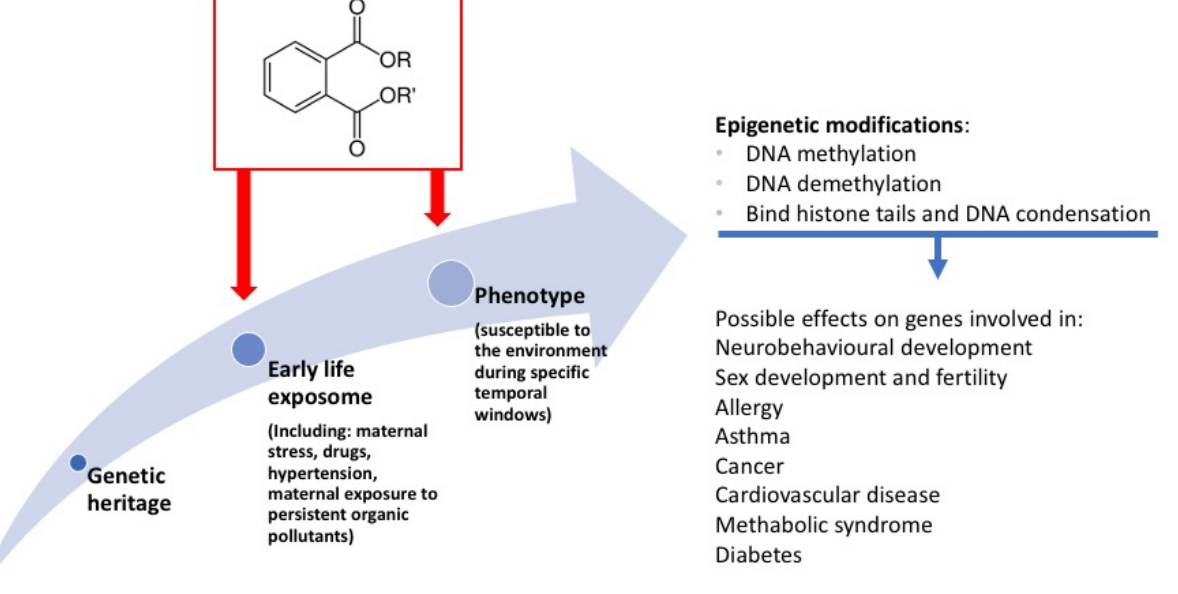
Figure 1. How phthalates may enter in The Development Origin of Health and Disease (DOHaD), causing epigenetic effects.